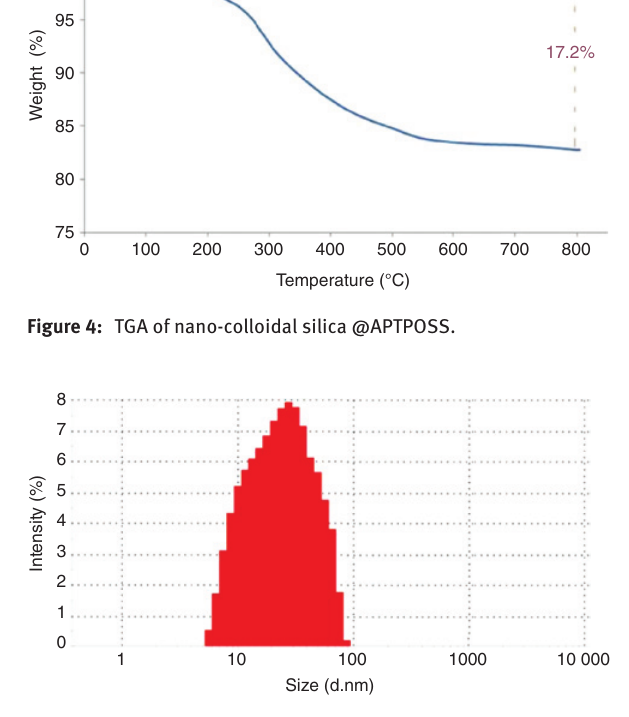
Figure 5: DLS of nano-colloidal silica